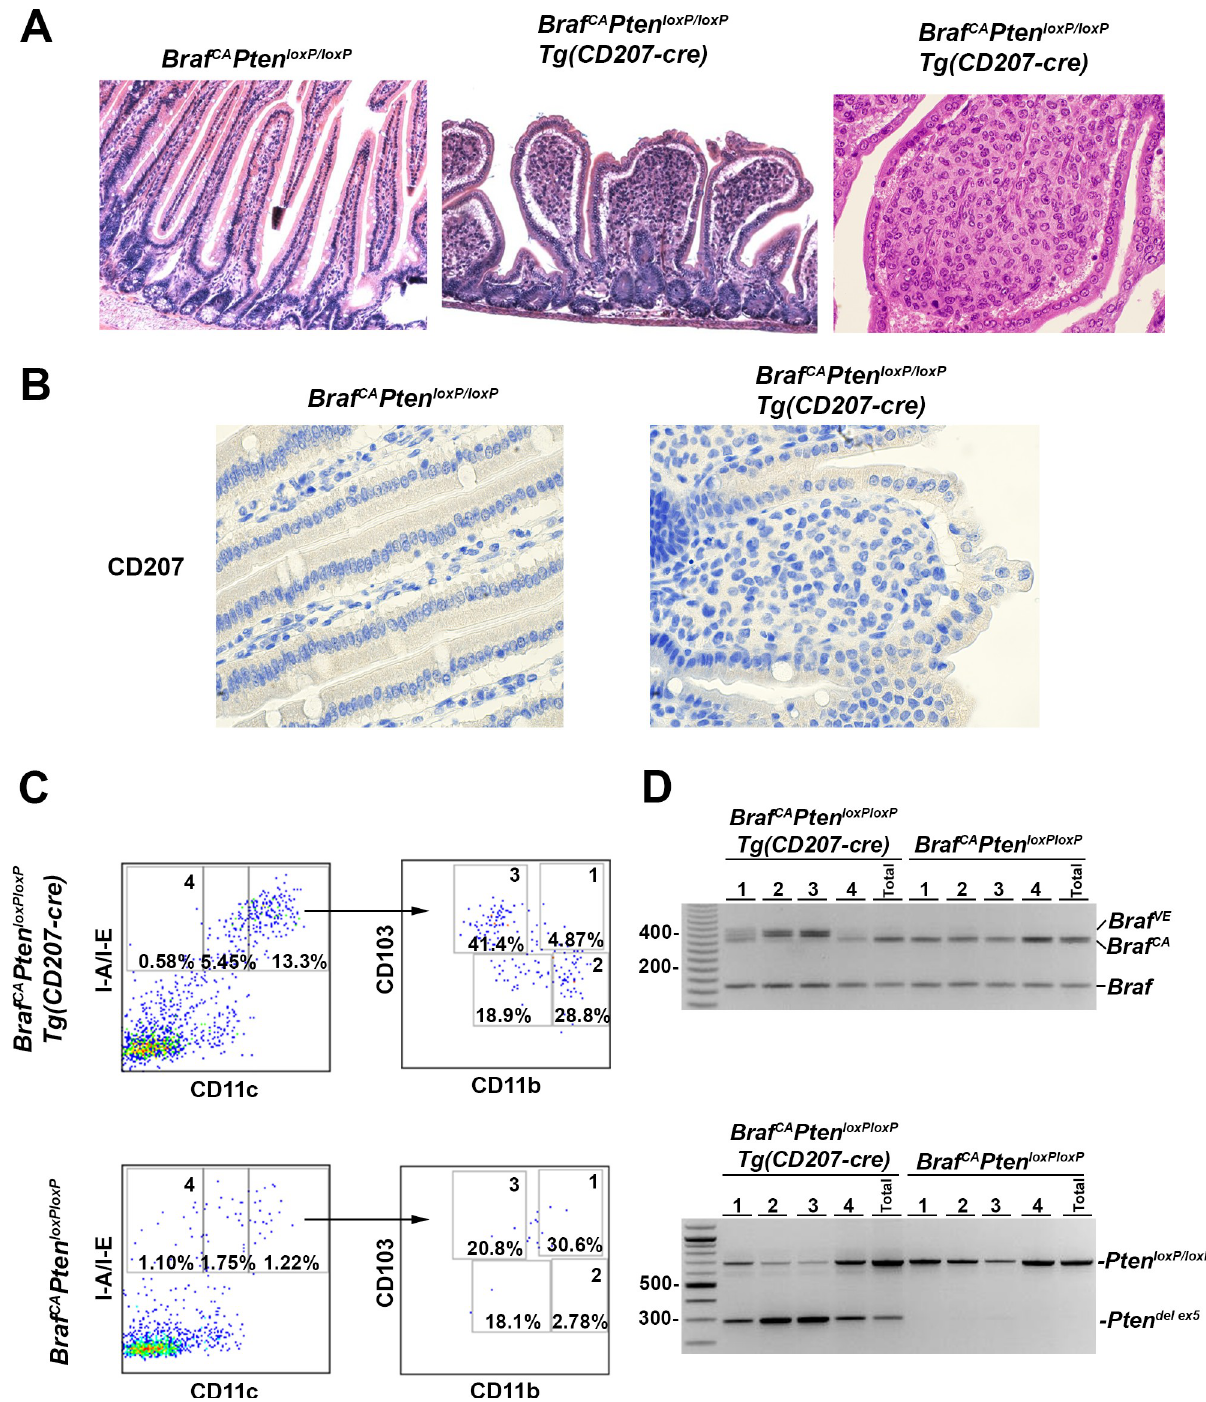
Fig 14. Accumulation of CD103 + /CD11b int and CD103 int /CD11b + cells in the small intestine of Braf CA Pten loxP/loxP Tg(CD207) mice. A. Hematoxylin and eosin staining of representative sections from the small intestine of Braf CA Pten loxP/loxP (left) and Braf CA Pten loxP/loxP Tg(CD207-cre) (middle) for 61 day old mice showing cellular accumulation distorting the villi in the latter. Original magnification, 100X (left and middle). Right, higher power view of infiltrating cells demonstrating their round-to-oval pleiomorphic nuclei and abundant eosinophilic cytoplasm in 29 day old mouse. Original magnification, 400X. B. CD207 immunohistochemical staining of the small intestine from Braf CA Pten loxP/loxP (left) and Braf CA Pten loxP/loxP Tg(CD207-cre) (right) 31 day old female mice. No CD207 expression could be detected (see Fig 15A for examples of positive staining). C. Cells from the small intestines of Braf CA Pten loxP/loxP Tg(CD207) and Braf CA Pten loxP/loxP 29 day old mice were sorted for I-A/I-E and CD11c. Double